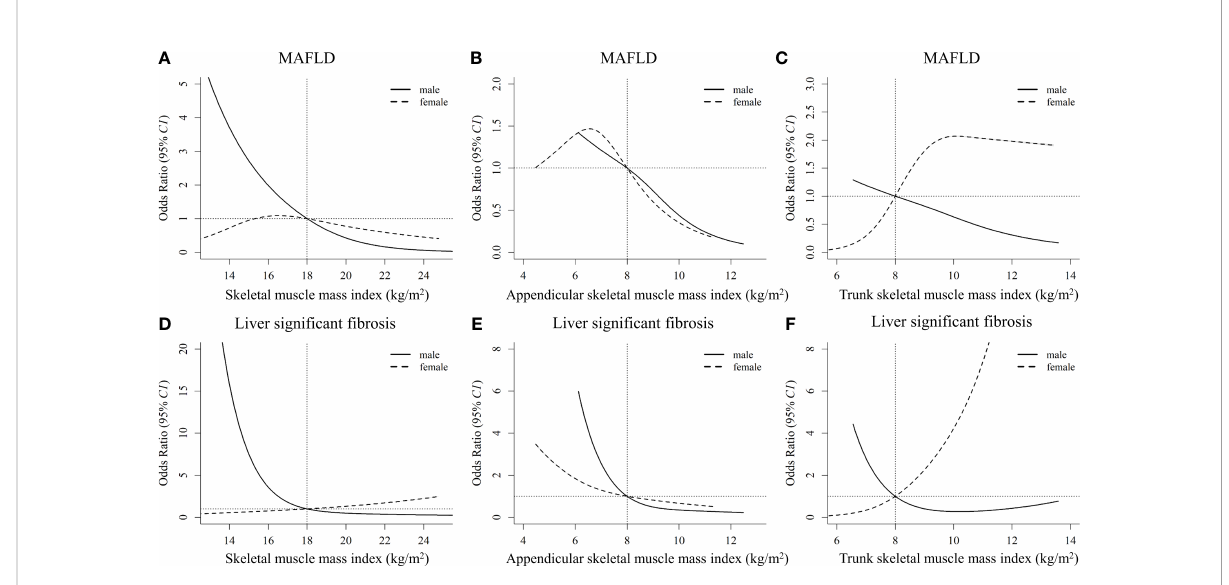
FIGURE 3 Nonlinear associations of muscle mass index with MAFLD and liver signi fi cant fi brosis by sexes (A) , (B) , and (C) stand for the whole-body skeletal muscle mass index, appendicular skeletal muscle mass index, and trunk skeletal muscle mass index with MAFLD, respectively. (D) , (E) , and (F) stand for the whole-body skeletal muscle mass index, appendicular skeletal muscle mass index, and trunk skeletal muscle mass index with liver signi fi cant fi brosis, respectively. The models are adjusted for age, race, education, poverty, married status, smoking, alcohol use, health